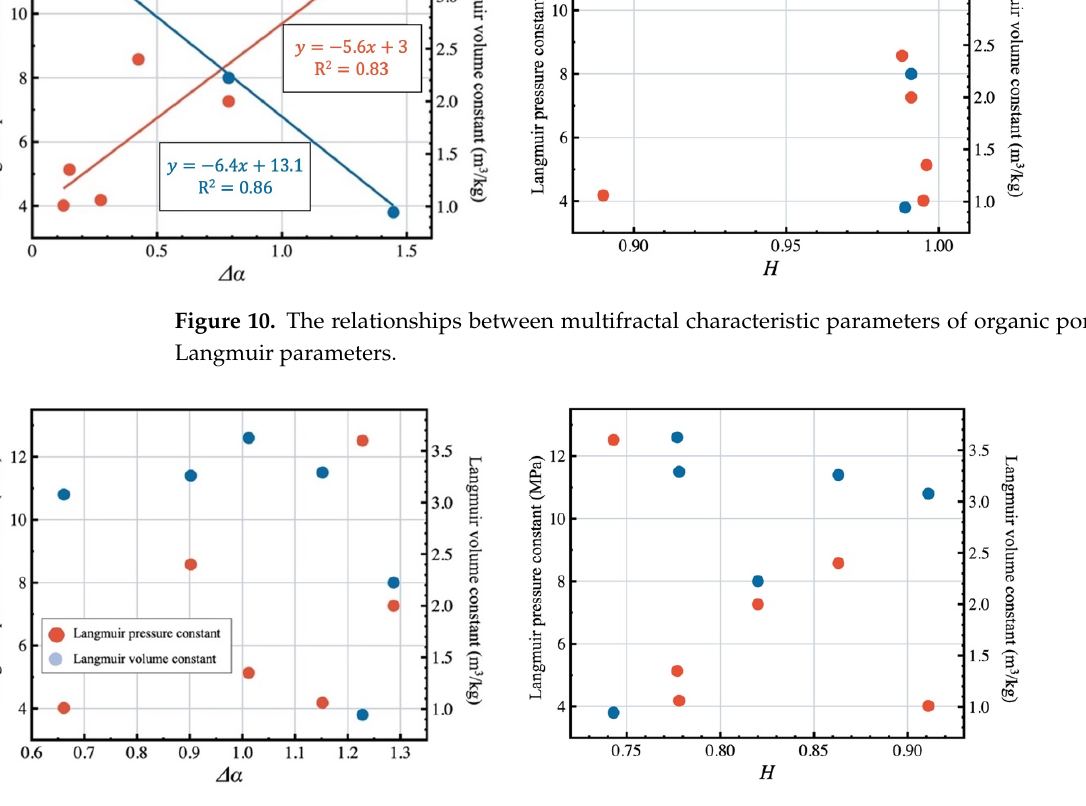
Figure 11. The relationships between multifractal characteristic parameters of inorganic pores and Langmuir parameters. Table 7. Langmuir parameters of shale samples.